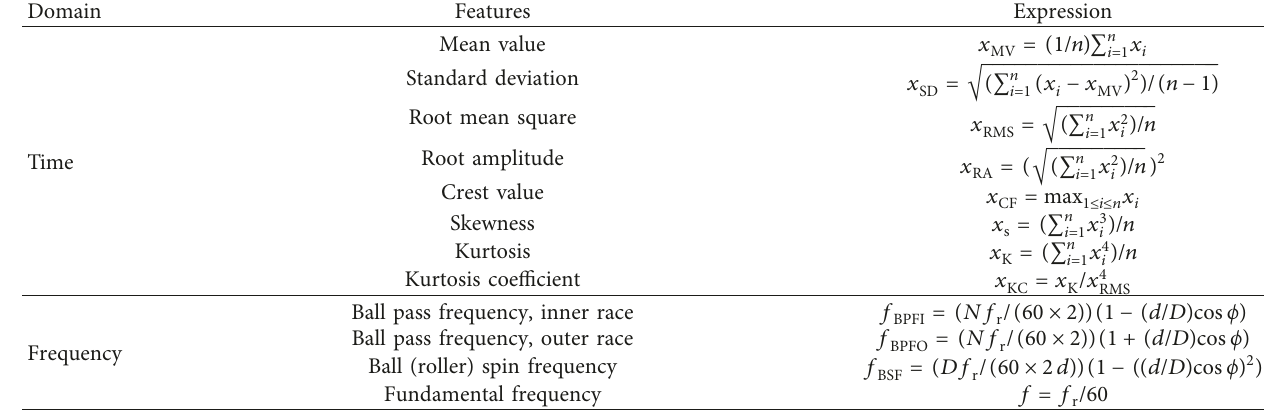
Table 1: List of extracted features.